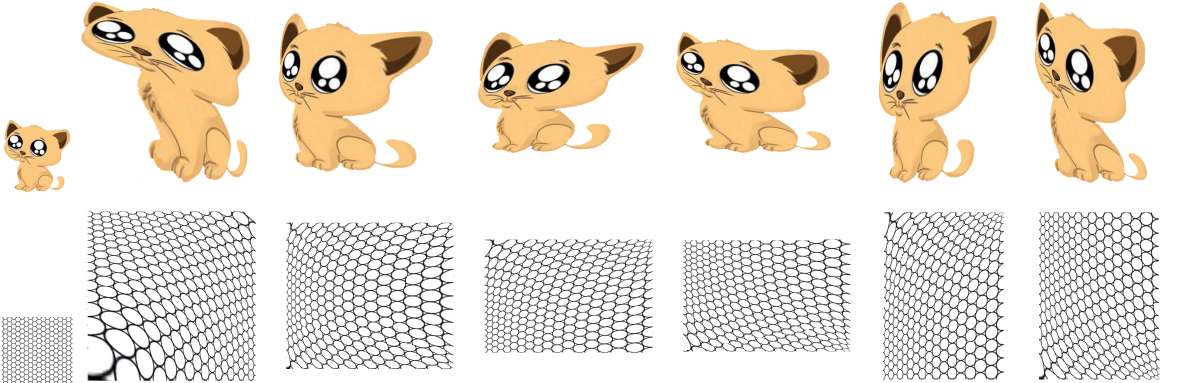
Figure 6. Animation with irregular deformations. The distortion of circles to ellipses visualizes the quasiconformality of